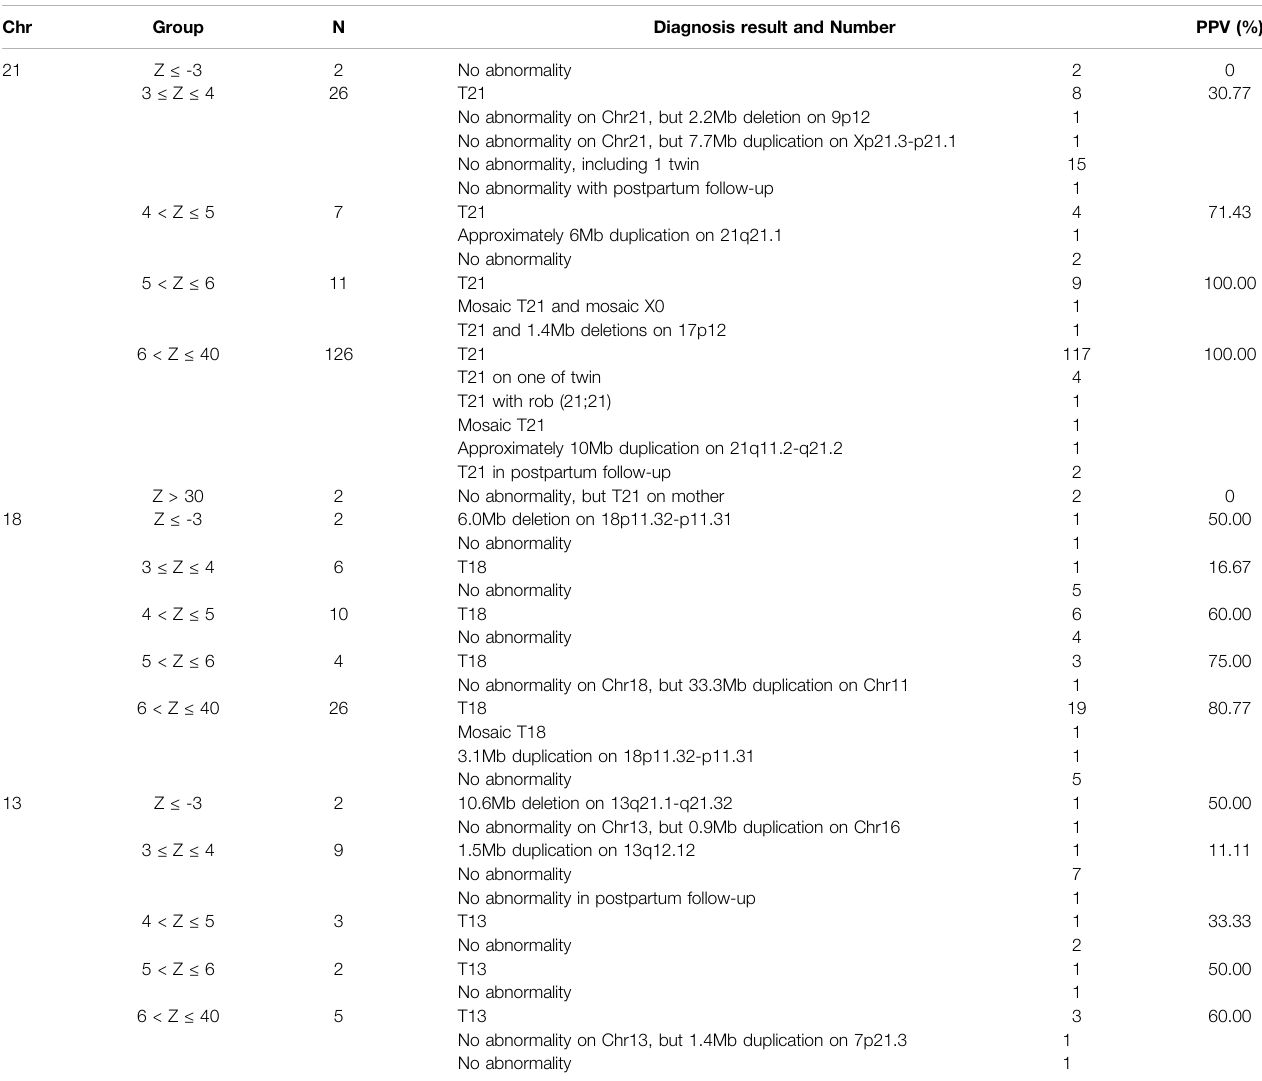
TABLE 4 | Comparison of NIPT Results and Diagnoses in Different